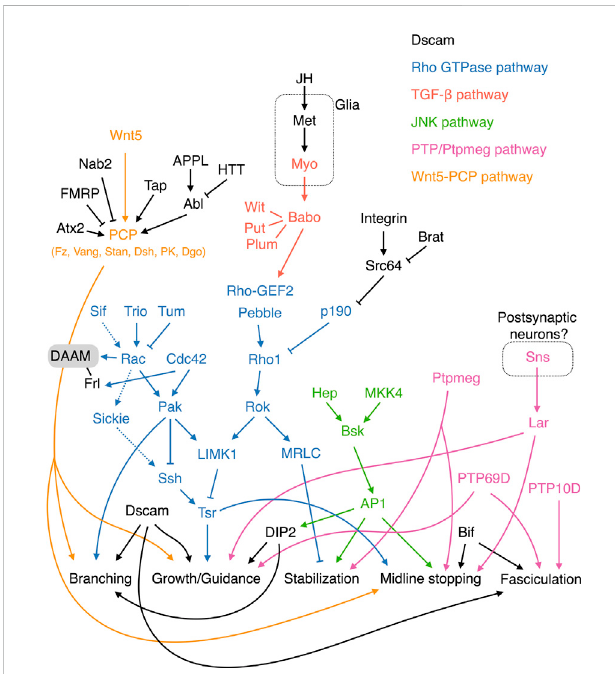
FIGURE 3 Molecular pathways regulating KC axonal development. The Wnt- PCP, Rho GTPase, TGF- β , JNK, and PTP/Ptpmeg pathways are colored orange, blue, red, green, and pink, respectively. Note that Tsr in the Rho GTPase pathway is phosphorylated by LIMK1 and dephosphorylated by Ssh. Cycles of Tsr phosphorylation (inactive